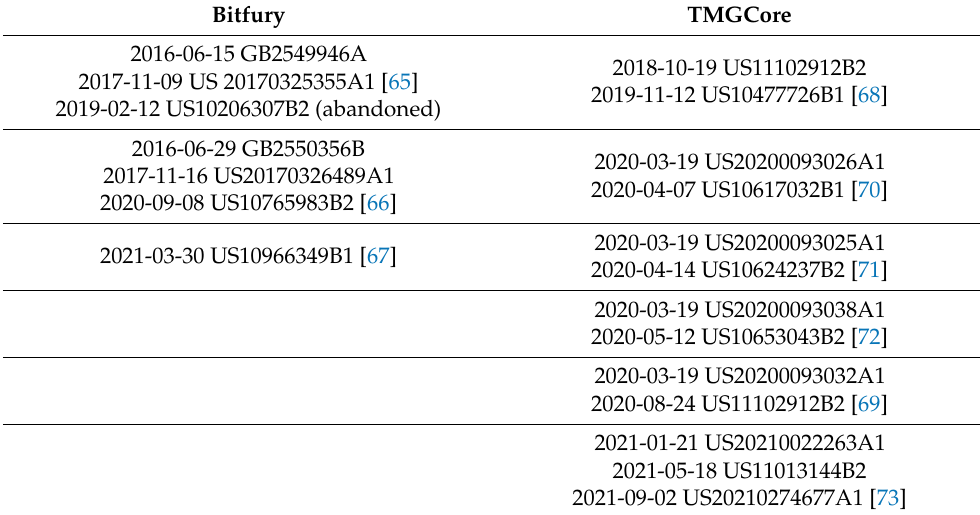
Table 5. Representative